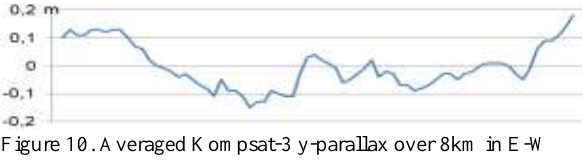
Figure 10. Averaged Kompsat-3 y-parallax over 8km in E-W